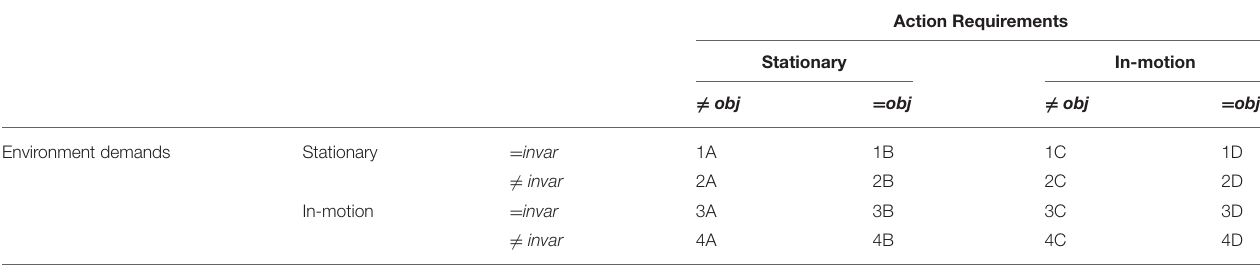
TABLE 1 | Gentile’s taxonomy of task complexity, including inter-trial variability and objects a .